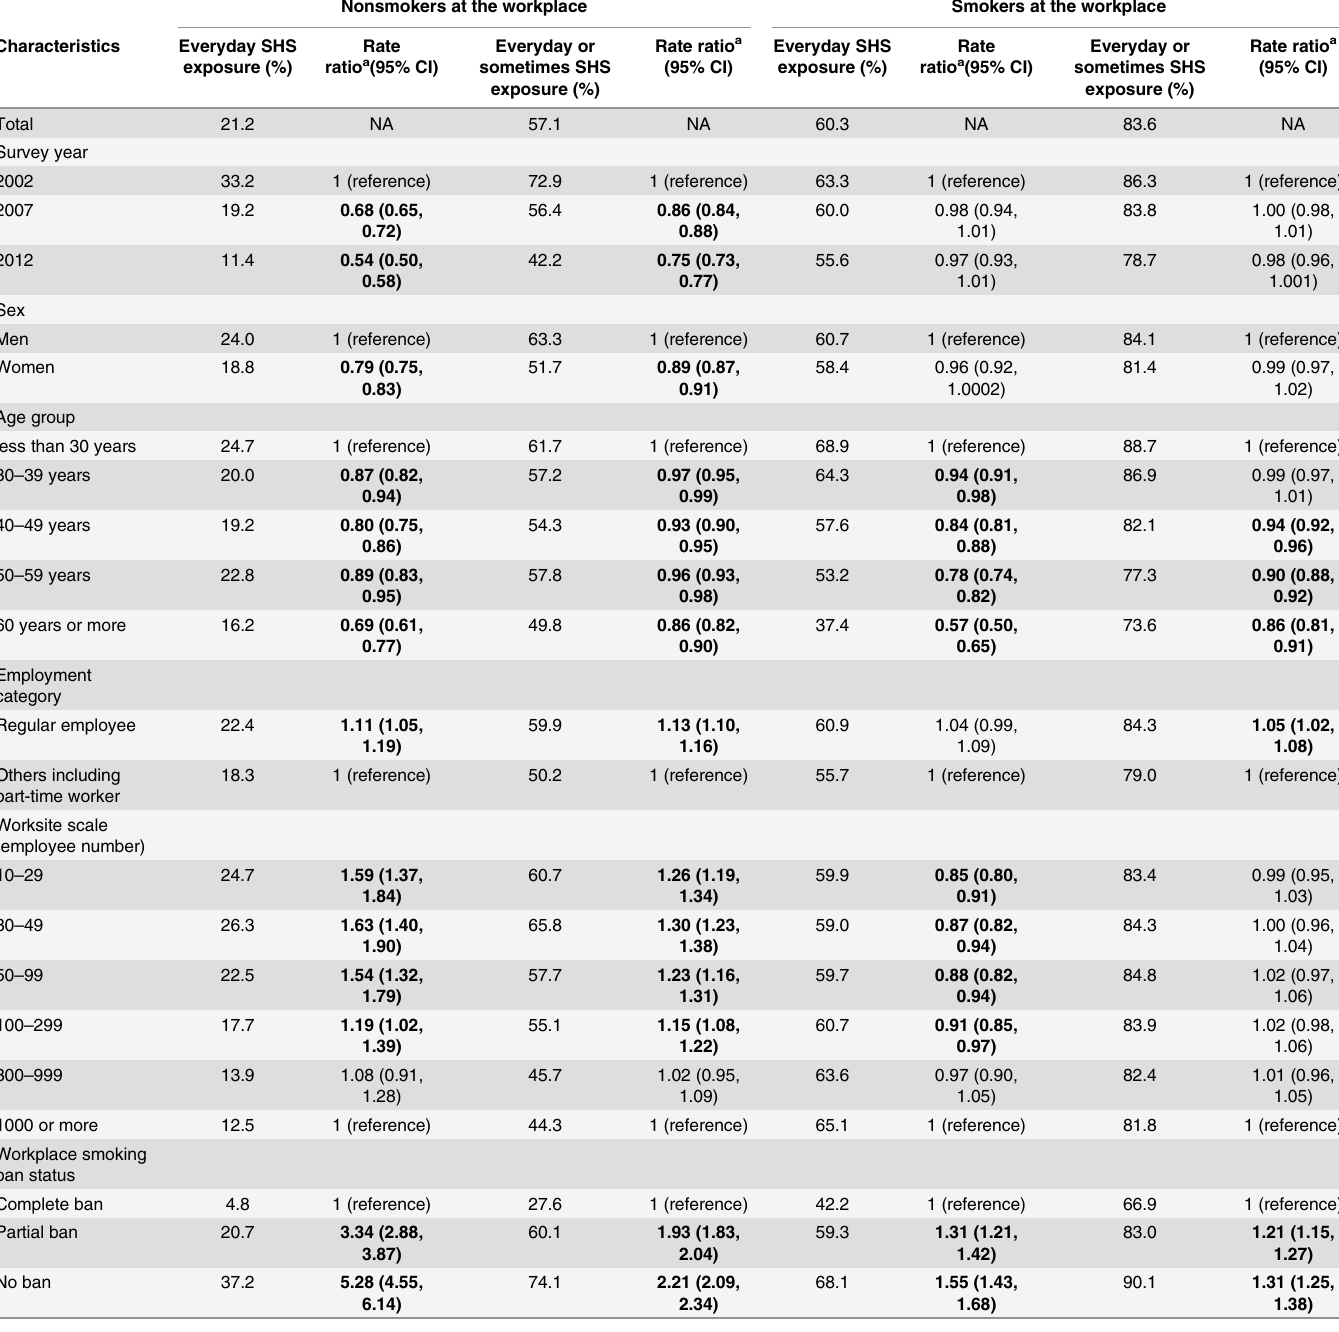
Table 3. Trends in prevalence and rate ratio for workplace SHS exposure from other people among employees according to characteristic, strati- fied by smoking status. Combined all years of 2002, 2007 and 2012 (weighted results). Nonsmokers at the workplace Smokers at the workplace